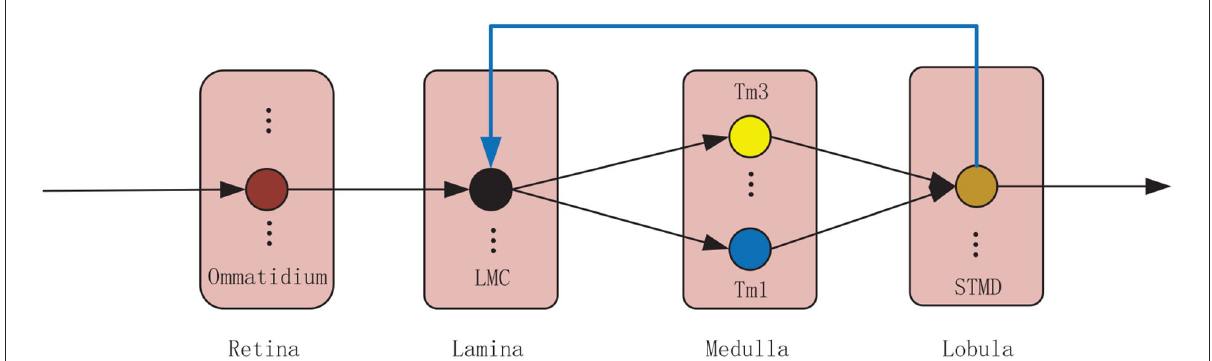
FIGURE1 Wiring sketches of the proposed model. The proposed model consists of four neural layers, including retina, lamina, medulla and lobula. Each neural layer contains numerous neurons illustrated by colored circular node. The small target motion detectors (STMDs) relay their outputs to lamina neurons via a feedback mechanism.